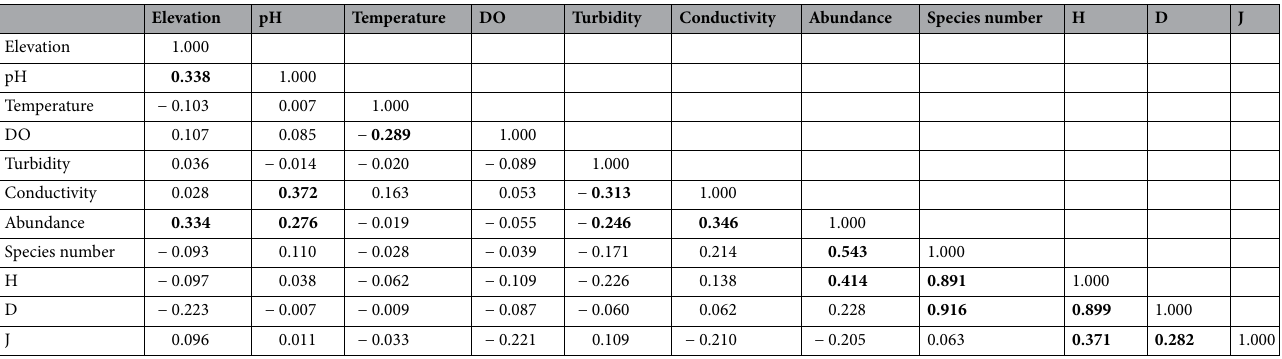
Table 4. Pearson correlation analysis between fish biodiversity and environmental parameters (n = 72). Significant value ( p value < 0.05) was indicated in bold.